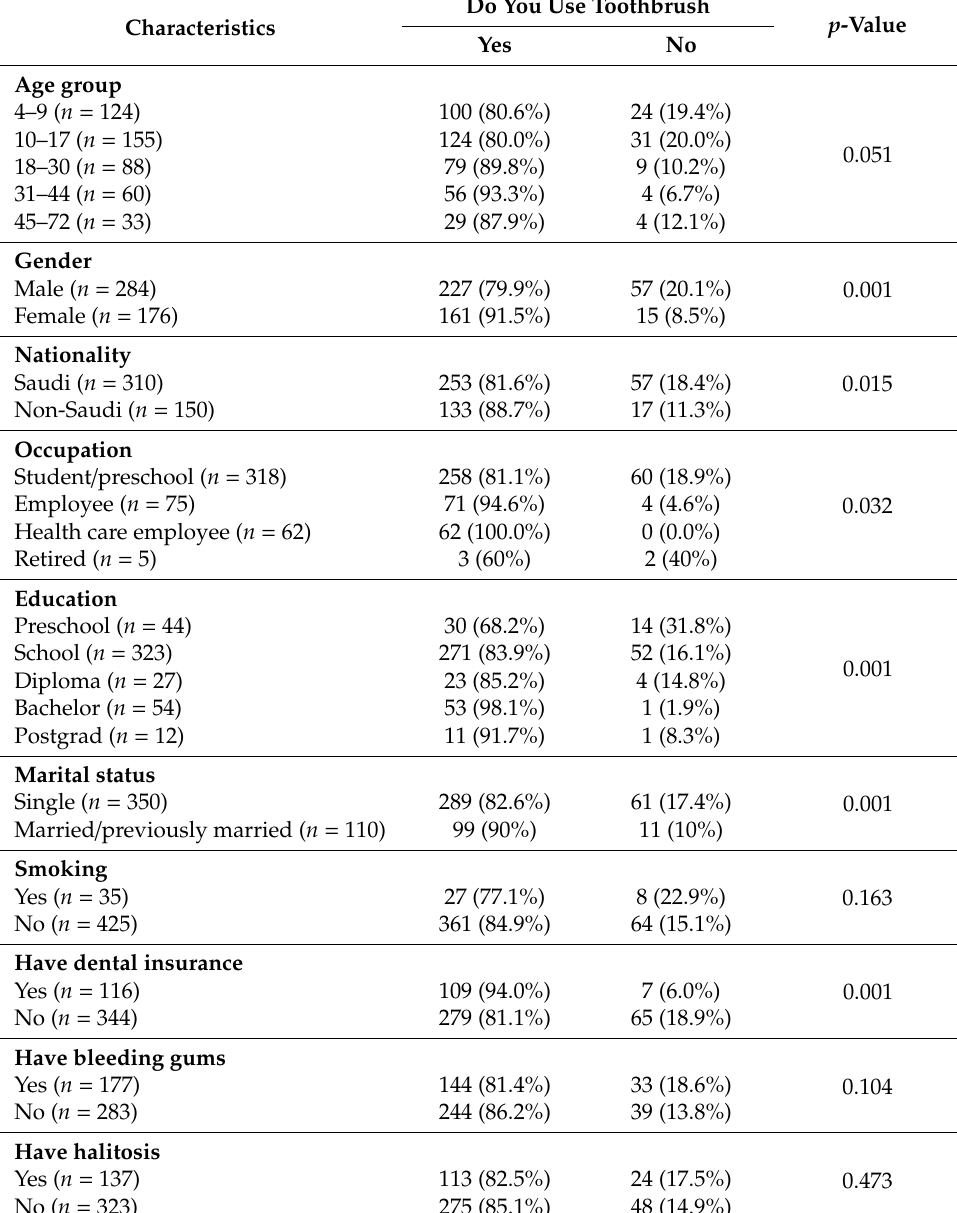
Table A1. Cross tabulation of toothbrush use and various